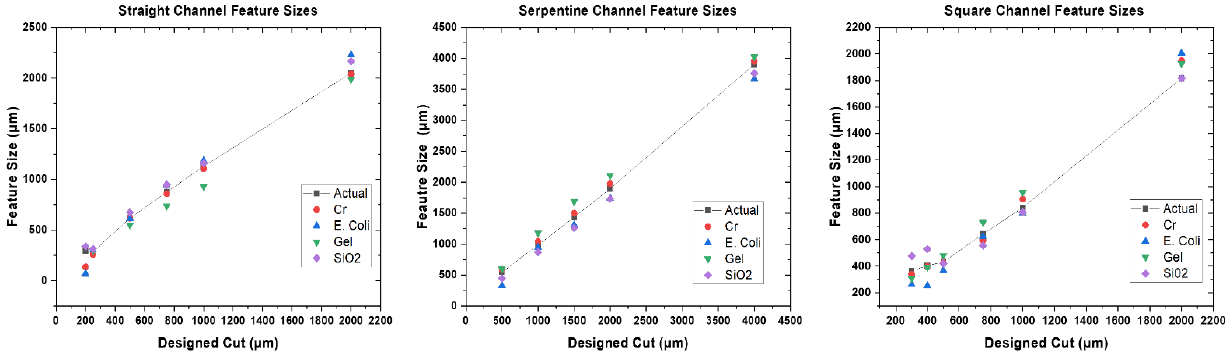
Figure 3. 3D confocal images images of “Good Cuts” depicting F22, F24, F26 Horizontally. The Cuts are 2 mm wide and 12.7 mm in length.